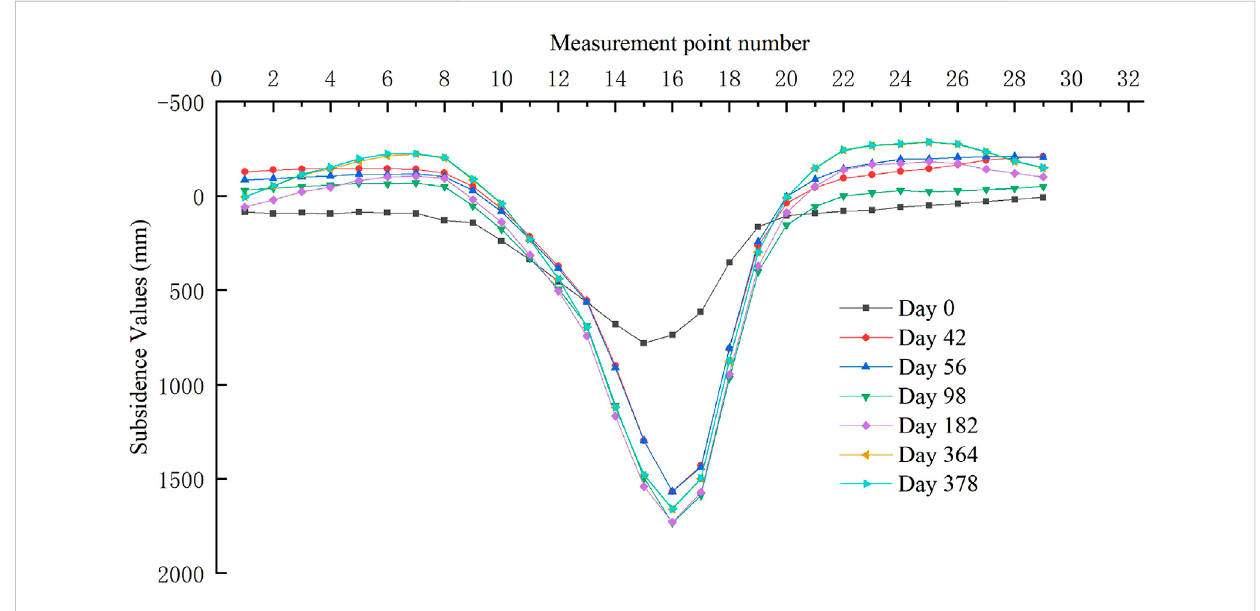
FIGURE 7 Dynamic curve of surface